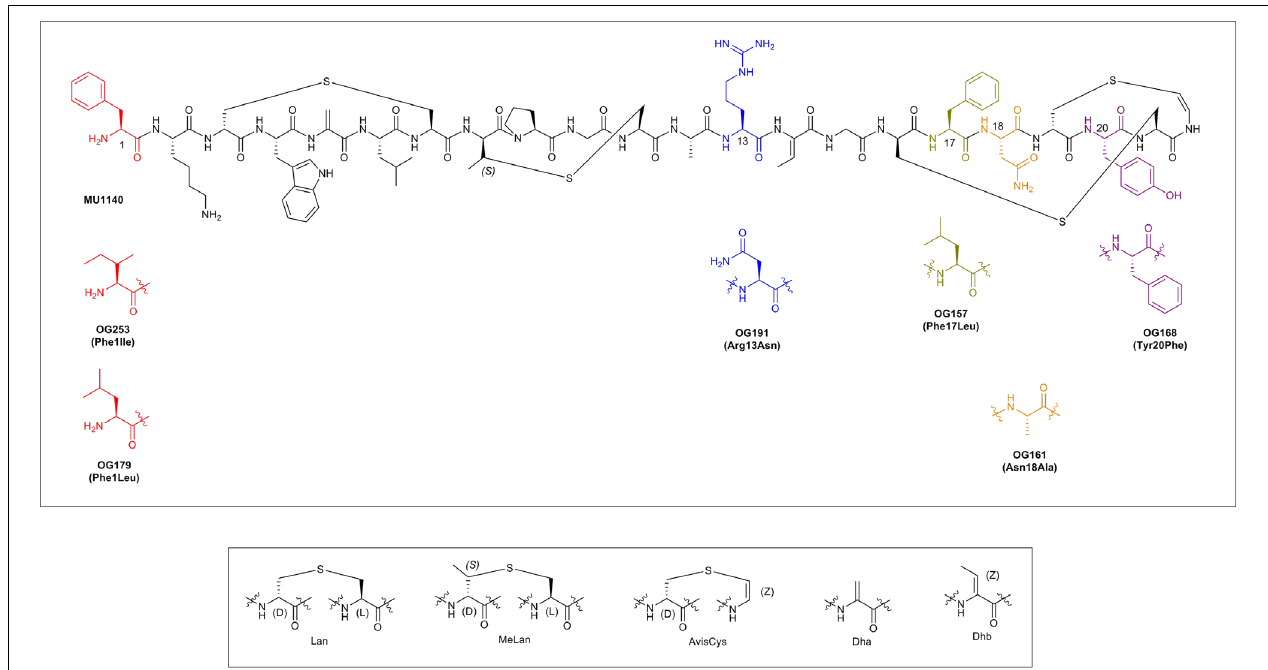
FIGURE 1 | The chemical structure of MU1140 and top 6 variants (top). Substitutions are displayed in parenthesis. Post-translationally modified residues in lantibiotics are presented in the (bottom).